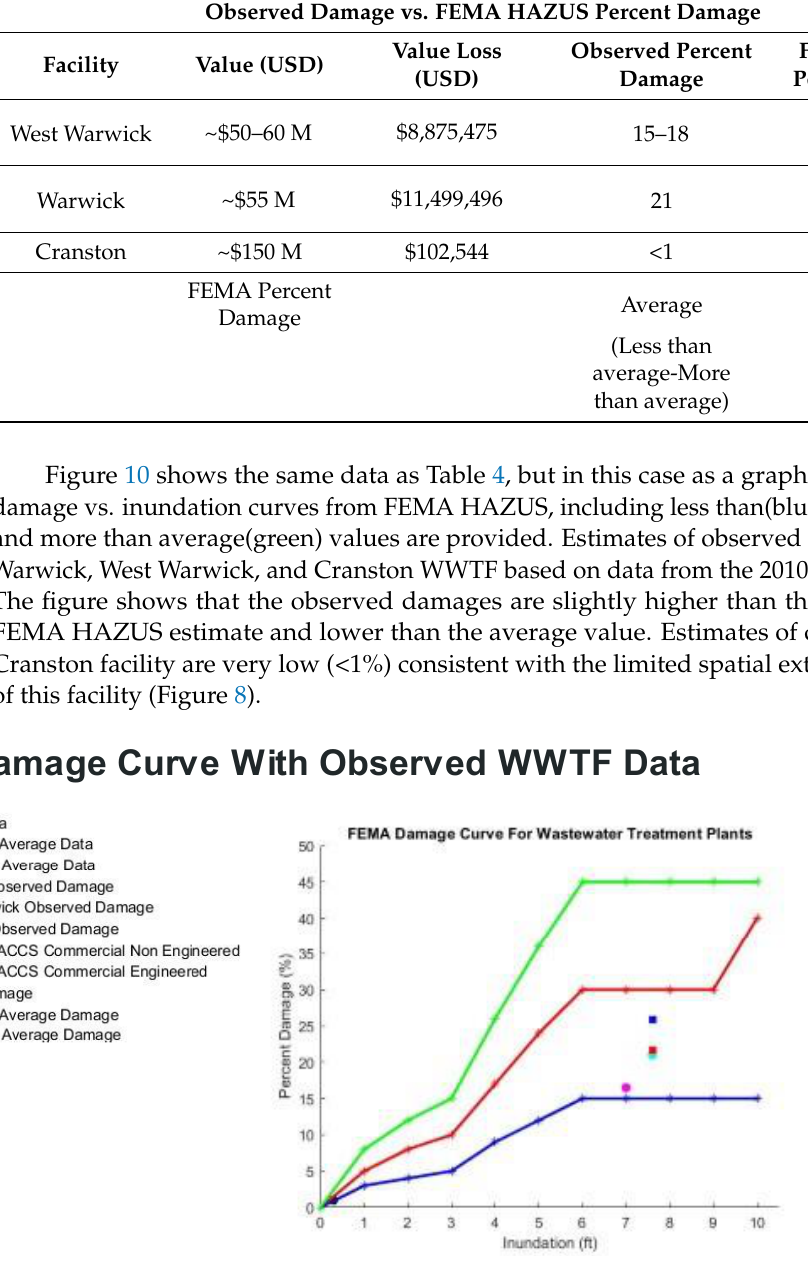
Table 4. Value, value loss, observed percent damage, and FEMA HAZUS based estimates of percent damage for West Warwick, Warwick, and Cranston WWTF. FEMA HAZUS average (less than and more than average) are provided.